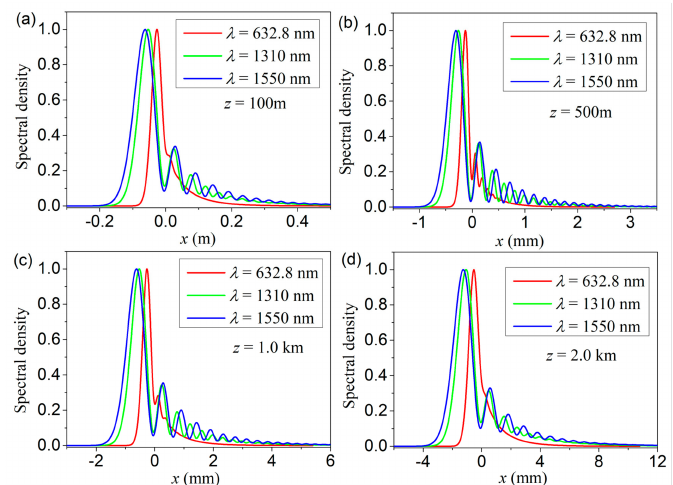
Figure 5. Normalized 1D spectral densities of the MCLGC beams with different wavelengths in turbulence at four different propagation distances. ( a – d ) the propagation distances are z = 100 m, 500 m, 1.0 km and 2.0 km,